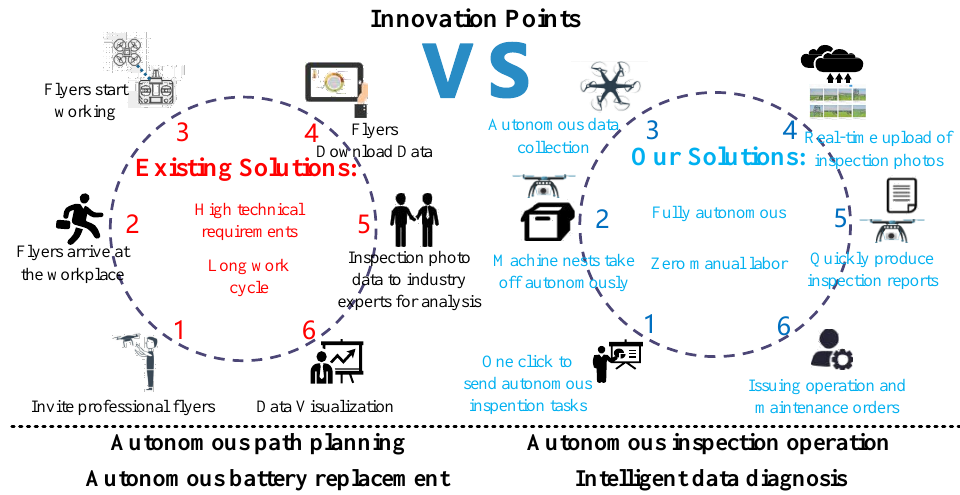
Figure 1. Comparison of the traditional inspection solution and our